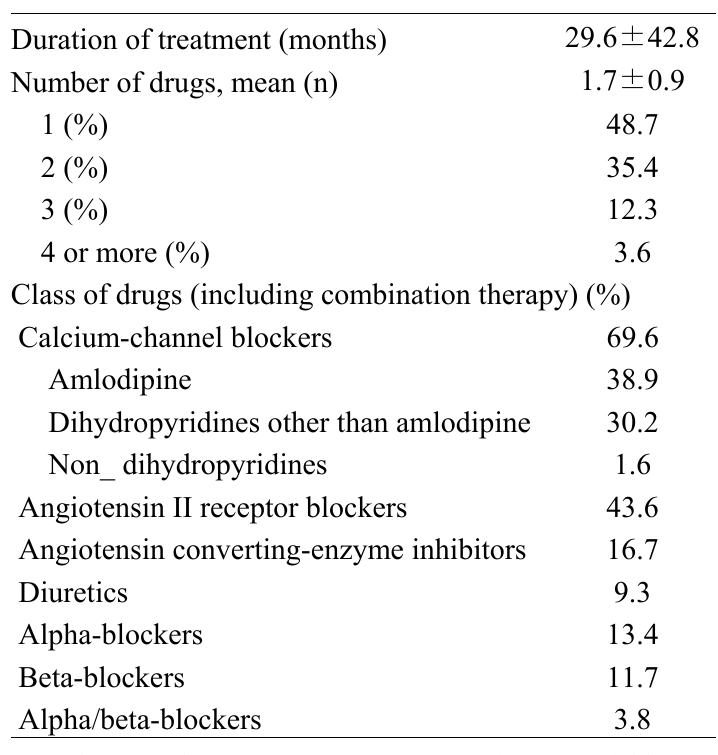
Table 2. Antihypertensive